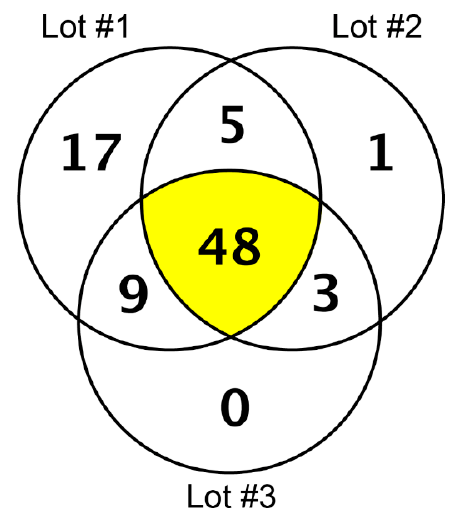
Figure 1. Proteins identified in three lots of the collagen membrane (Bio-Gide) by high-resolution shotgun proteomic analysis.